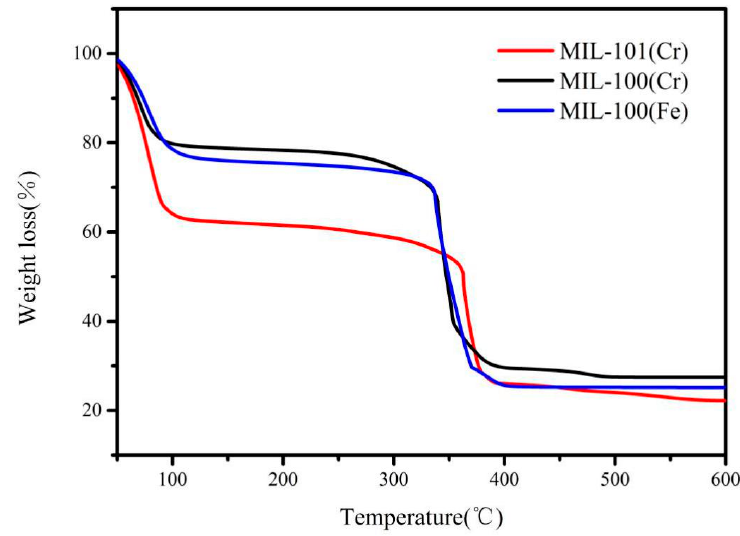
Figure 2. Thermal gravimetric analysis (TGA) profiles of MIL-100(Fe, Cr), MIL-101(Cr).